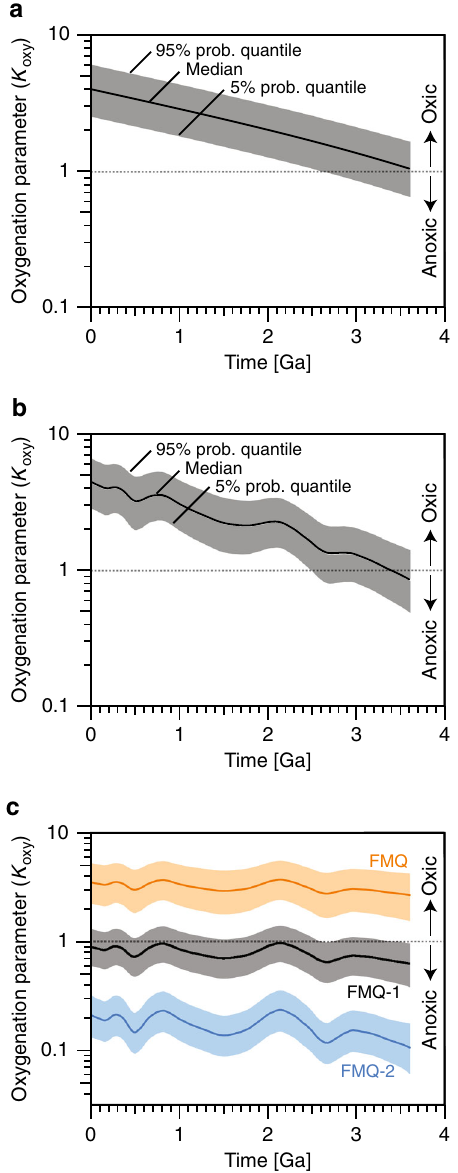
Fig. 2 Evolution of the dimensionless oxygenation parameter, K oxy . Solid lines represent median values, and the shaded region bounds 5% to 95% probability quantiles. These are obtained by 10,000 times Monte-Carlo simulations. Gray dotted lines highlight K oxy = 1, above which the atmosphere is oxic; otherwise, it is anoxic. a Organic burial fraction is constant at 20%, and the secular increase in the oxygen fugacity of mantle in Fig. 1b is considered. b Both a change in organic burial fraction from Krissansen-Totton et al. 24 and secular increase in the oxygen fugacity in Fig. 1b are considered. c Oxygen fugacity is assumed to be constant at three different levels (blue: FMQ-2, black: FMQ-1, orange: FMQ). The fl uctuations come from imposed changes in organic burial fraction. In b , the parameter K = 95% oxy exceeds unity by ~2.5 Ga with >